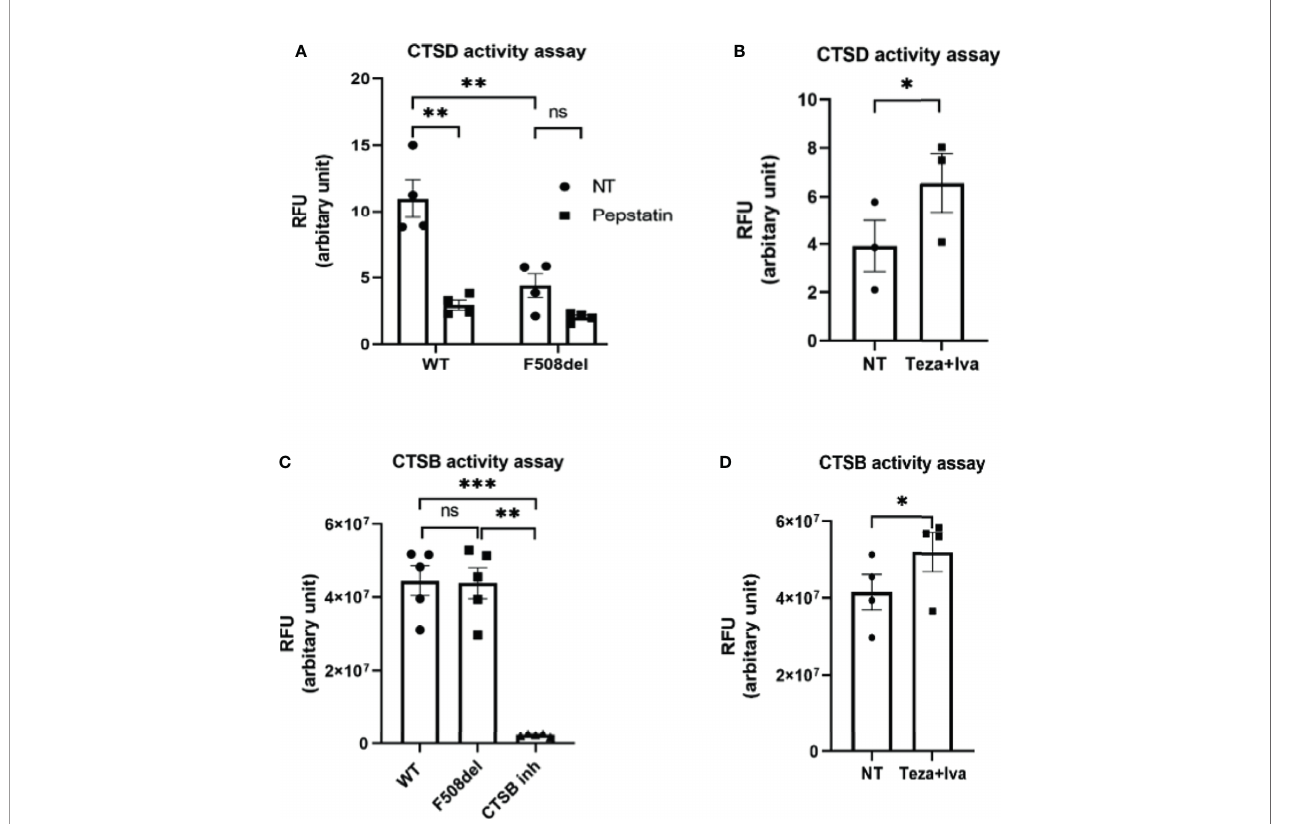
FIGURE 4 | The lysosomal enzyme cathepsin D shows reduced proteolytic activity in F508del macrophages. (A) Cathepsin D (CTSD) activity in wild-type (WT) and F508del macrophages either non-infected (NT) or treated with pepstatin (20 µg/ml). Data show mean fl uorescence intensity (MFI) of Bodipy-pepstatin normalized to the number of cells. Data represent mean ± SEM (n = 4 biological replicates). Statistical analysis was done using two-way ANOVA; **, p ≤ 0.01; ns, non-signi fi cant. (B) CTSD activity in F508del macrophages NT (plotted in A ) or treated with Teza + Iva. Data show MFI of Bodipy-pepstatin normalized to the number of cells. Data represent mean ± SEM (n = 3 biological replicates). Statistical analysis was done using one-way ANOVA; *, p ≤ 0.0.5. (C) Cathepsin B (CTSB) activity in WT and F508del either NT or treated with CTSB inhibitor. Data show mean fl uorescence intensity per 10 µg of total protein. Data represent mean ± SEM (n = 5 biological replicates). Statistical analysis was performed using two-way ANOVA; ** p ≤ 0.01; *** p ≤ 0.001; ns, non-signi fi cant. (D) CTSB activity in F508del either NT (plotted in C ) or treated with Teza+Iva for 24 h. Data show MFI per 10 µg of total protein. Data represent mean ± SEM (n = 4 biological replicates). Statistical analysis was performed using paired t-test; *, p ≤